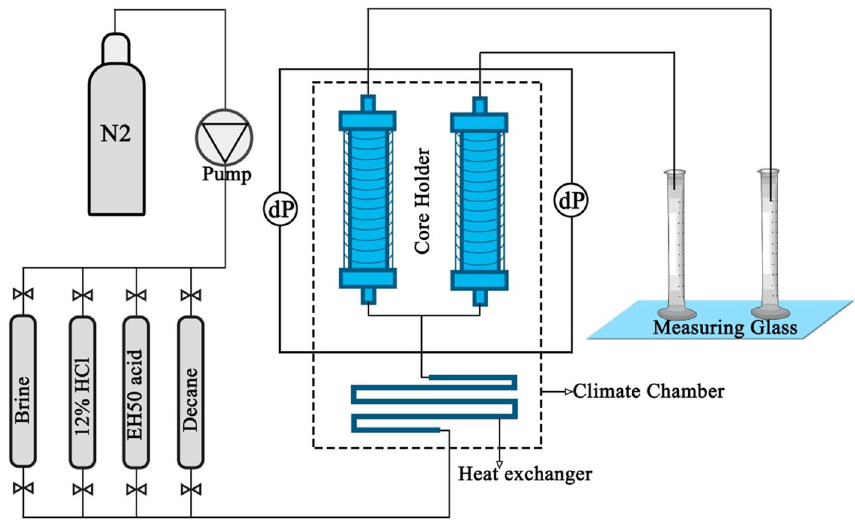
Fig. 1 Schematic of the flow experimental setup